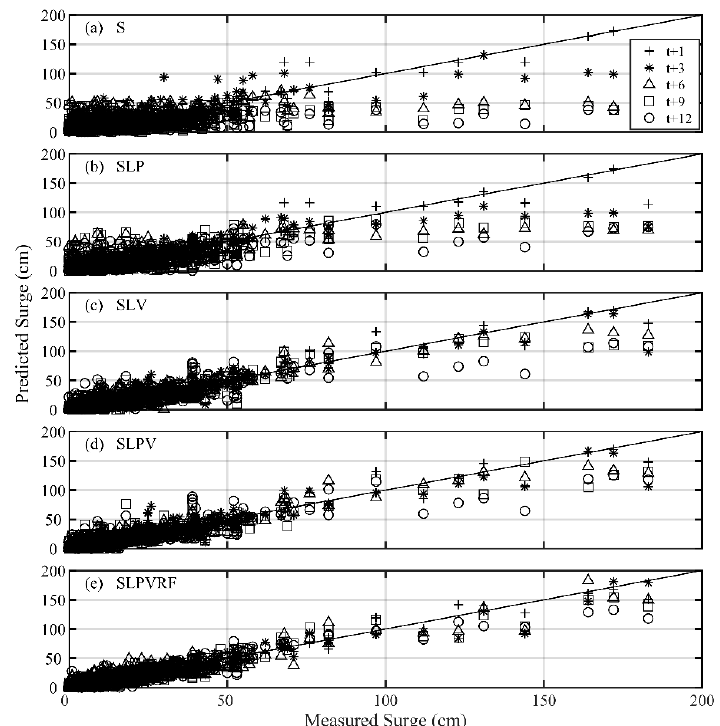
Figure 8. Scatter plots of predicted and measured storm surges for all training events under different input combinations (from top to bottom panels) and lead-time (various symbols): ( a ) S , ( b ) SLP, ( c ) SLV, ( d ) SLPV, and ( e ) SLPVRF.